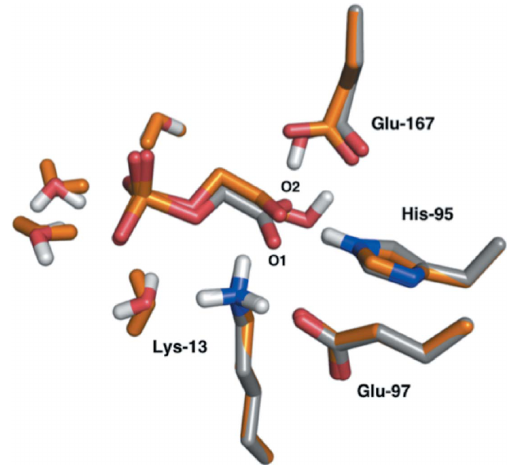
Figure 7 Superposition of the QM/MM-optimized structure of DHAP–TIM (orange) and the quantum-refined structure of PGA–TIM (grey).